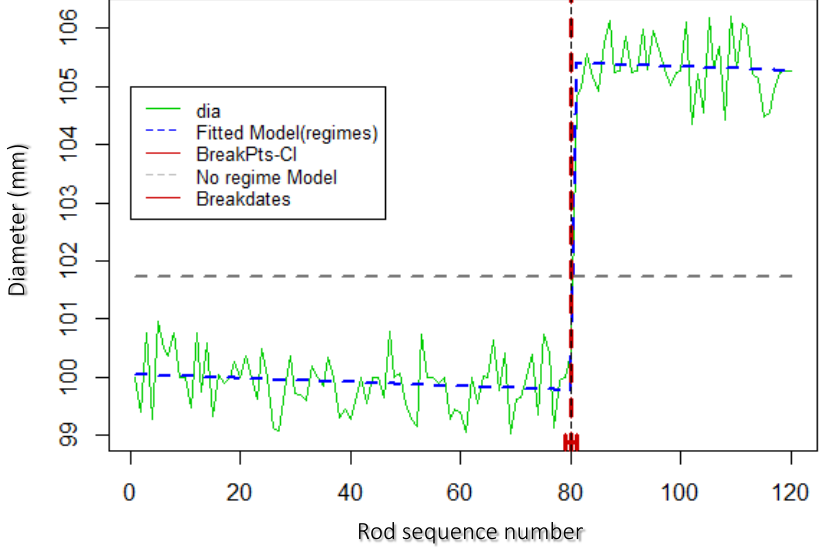
Figure 7. Break date and segmented model.